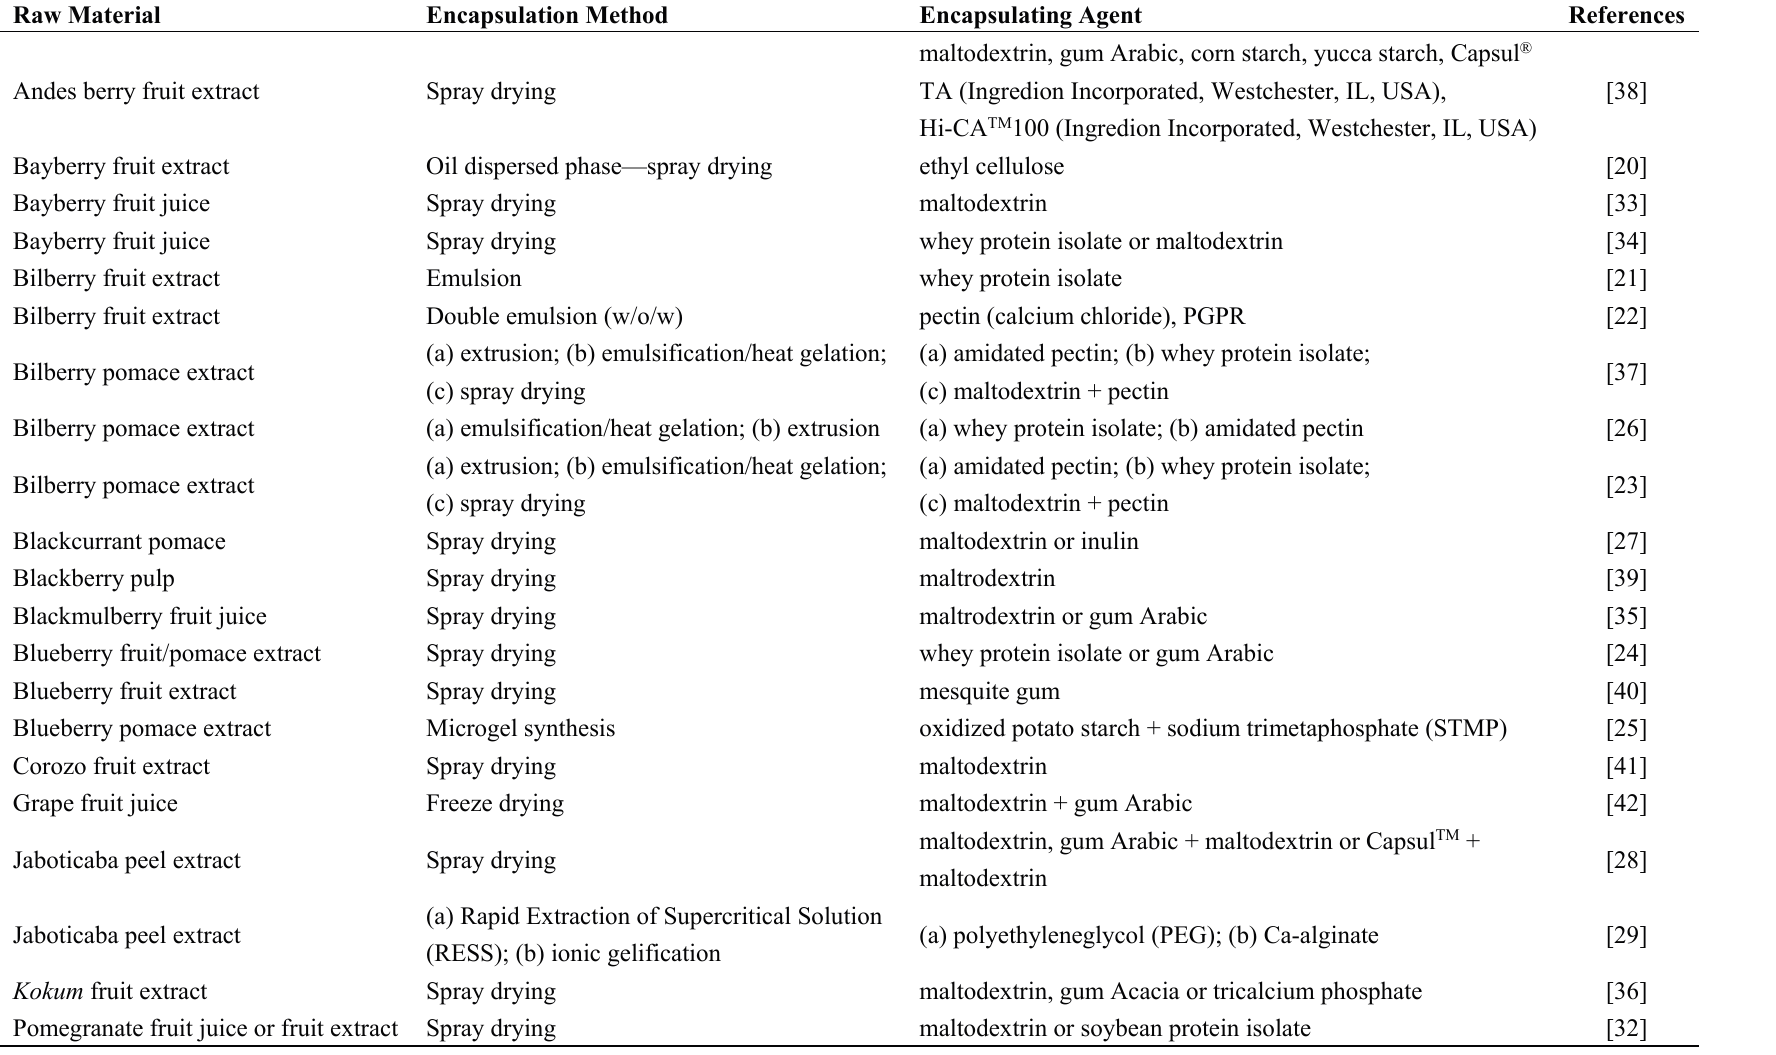
Table 1. The encapsulation of anthocyanins from different berry-type